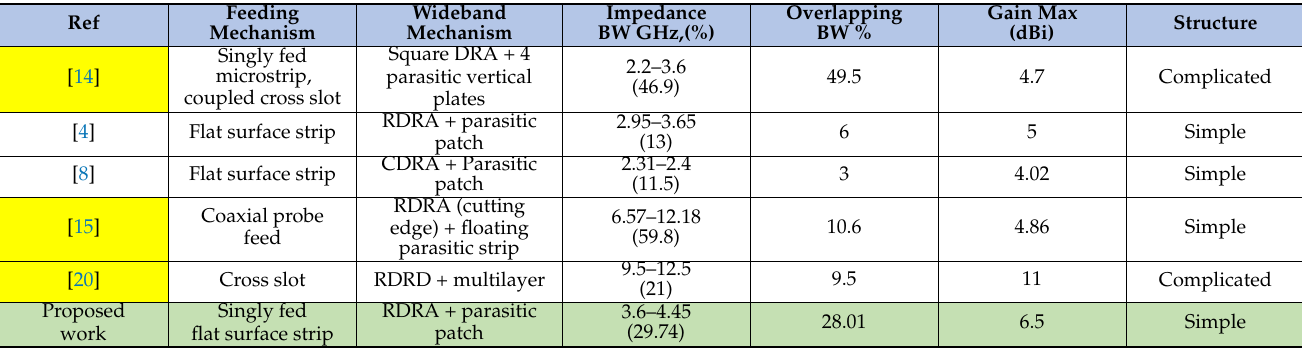
Table 4. Analysis with earlier published work in